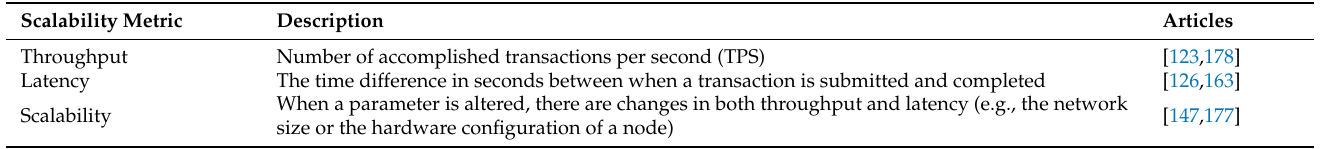
Table 15. Identified scalability